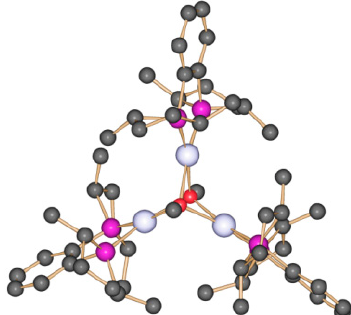
Figure 18. Molecular structure of the cation [Rh 3 (Me-DuPhos) 3 ( µ 3 -OMe) 2 ] + . Hydrogen atoms are omitted for clarity.